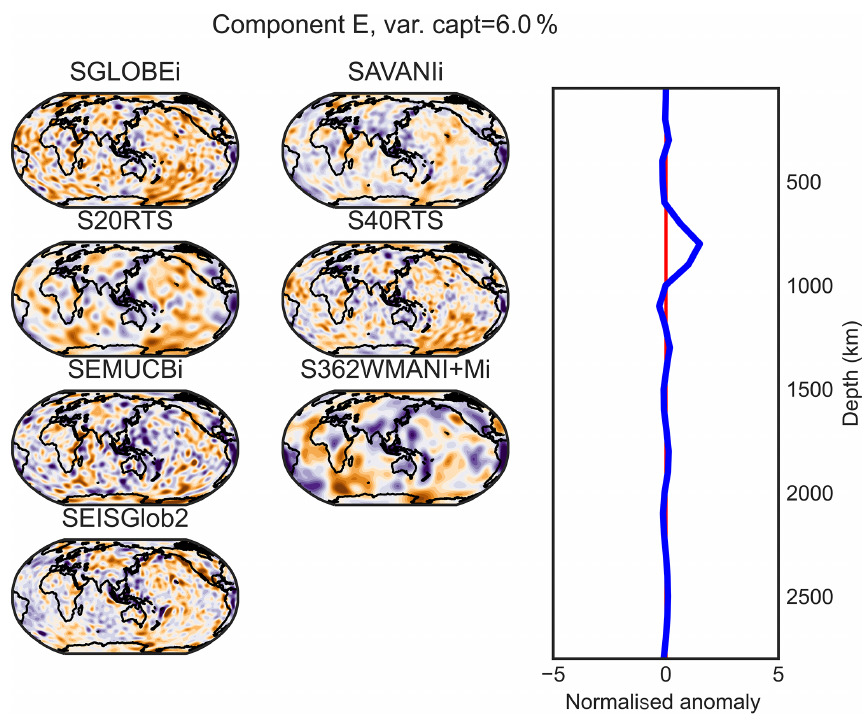
Figure D5. PC E (maximum at 800km of depth) of the combined analysis of the isotropic parts of the models.